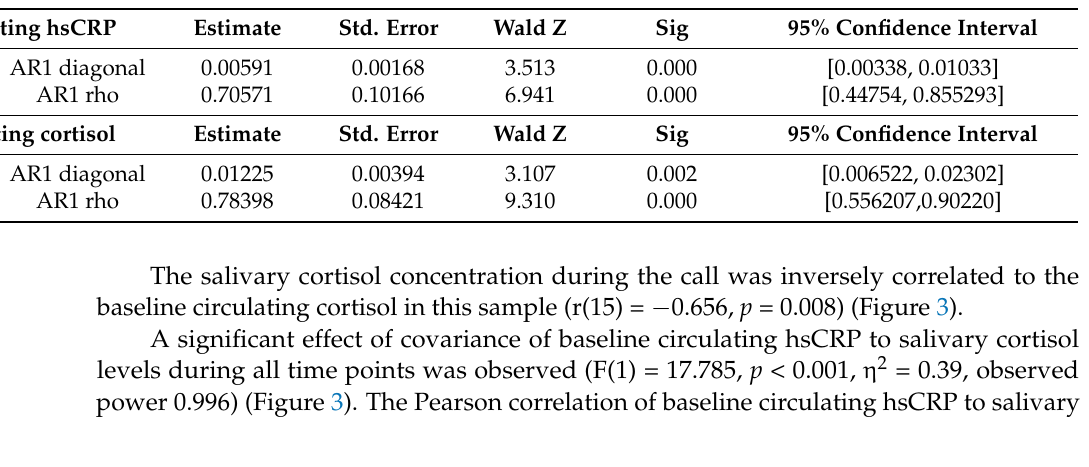
Table 5. Estimates of covariance parameters baseline circulating hsCRP and cortisol (n =